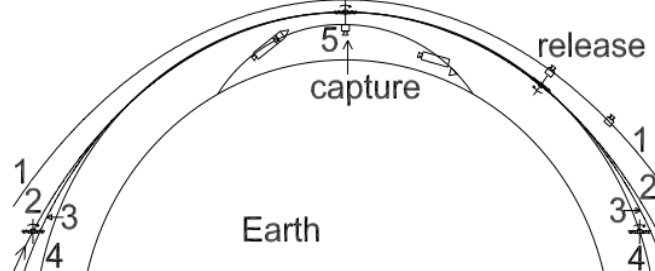
Figure 1. Orbital geometry of the LEO bolo (rotovator) launch assistance mission. (1) payload post-release orbit; (2) tether pre-capture orbit; (3) tether and payload post-capture orbit; (4) tether post-release orbit (circular); (5) payload pre-capture sub-orbital